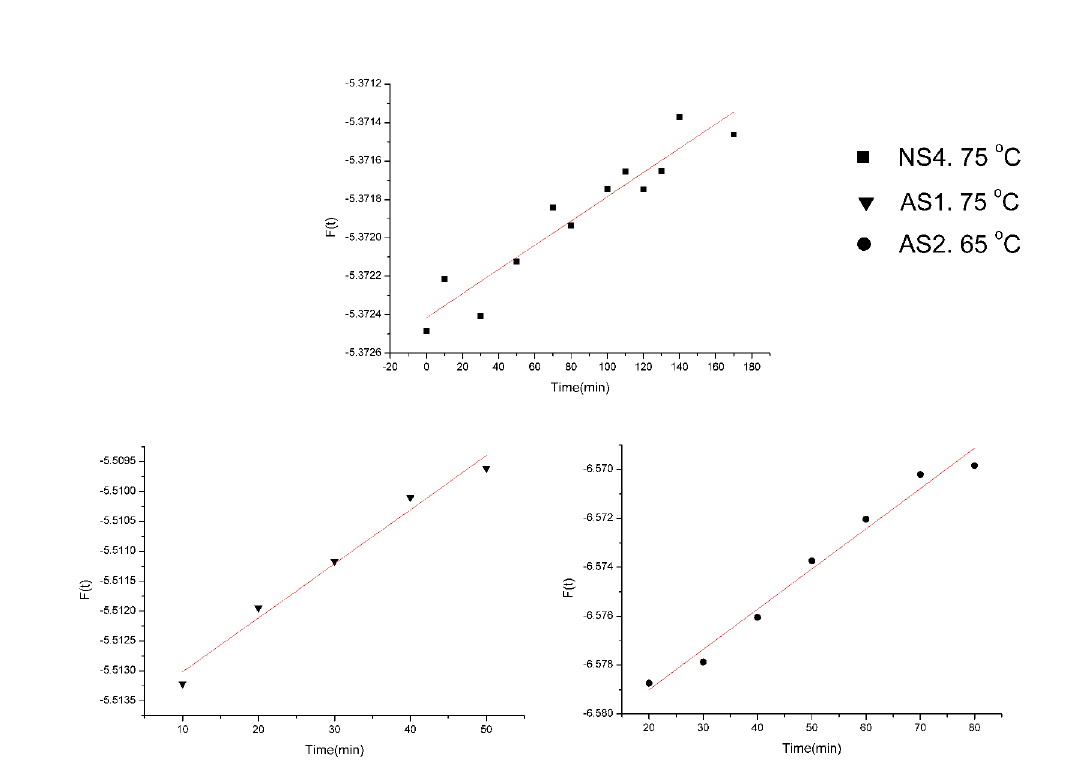
Figure 13. Straight lines obtained for one experiment using soot and for two experiments using active silica, in the integral analysis.